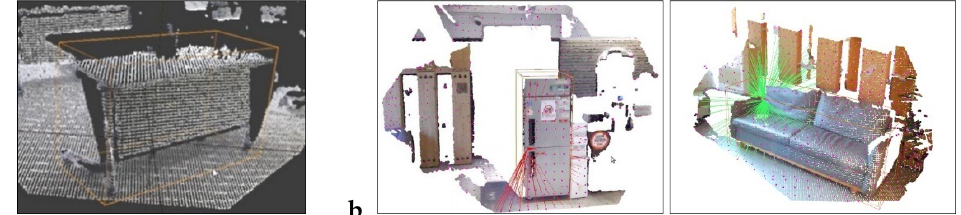
Figure 6. ( a ) Learning labeling box of improved point-GNN and ( b ) key-point graph of object pose estimation.